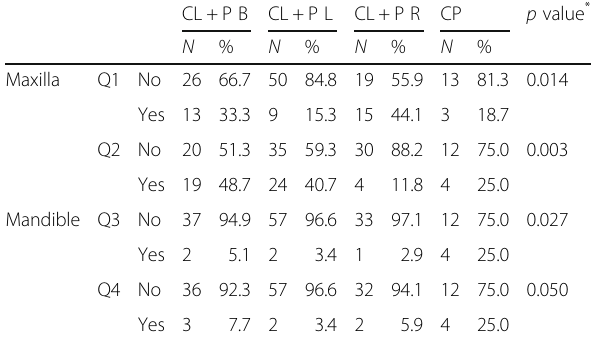
Table 6 Tooth agenesis by quadrant in maxilla and mandible and by cleft type CL + P B CL + P L CL + P R CP